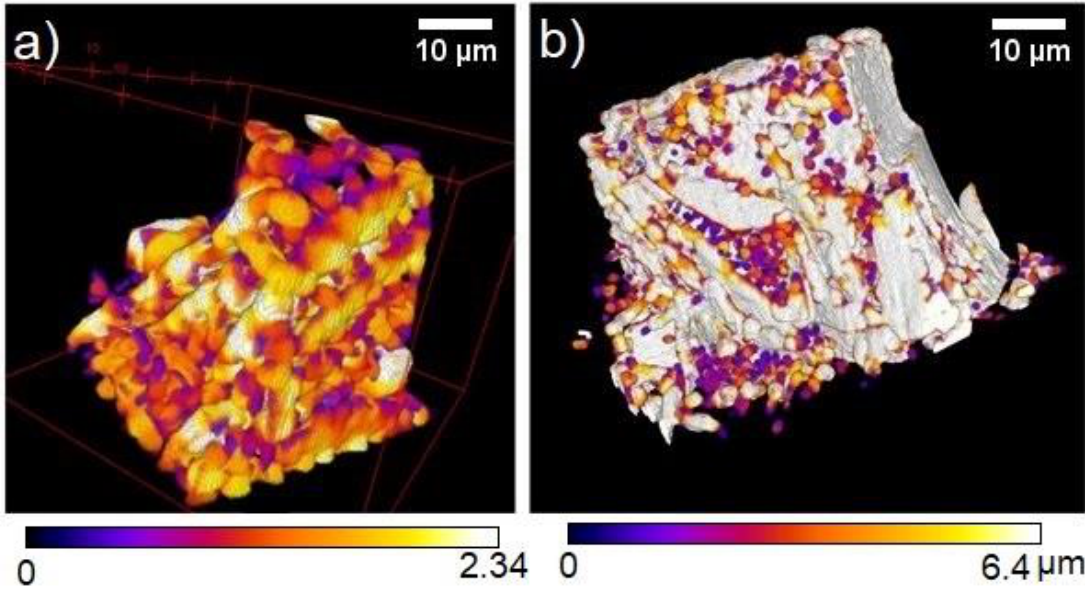
Figure 4. Colorized tomographic images of the open porous TiMo alloy obtained by dealloying at 800 ◦ C for 10 min ( a ) and 900 ◦ C for 5 min ( b ). Note: colors reflect thickness of ligaments; yellow corresponds to thicker and blue to thinner ligaments.